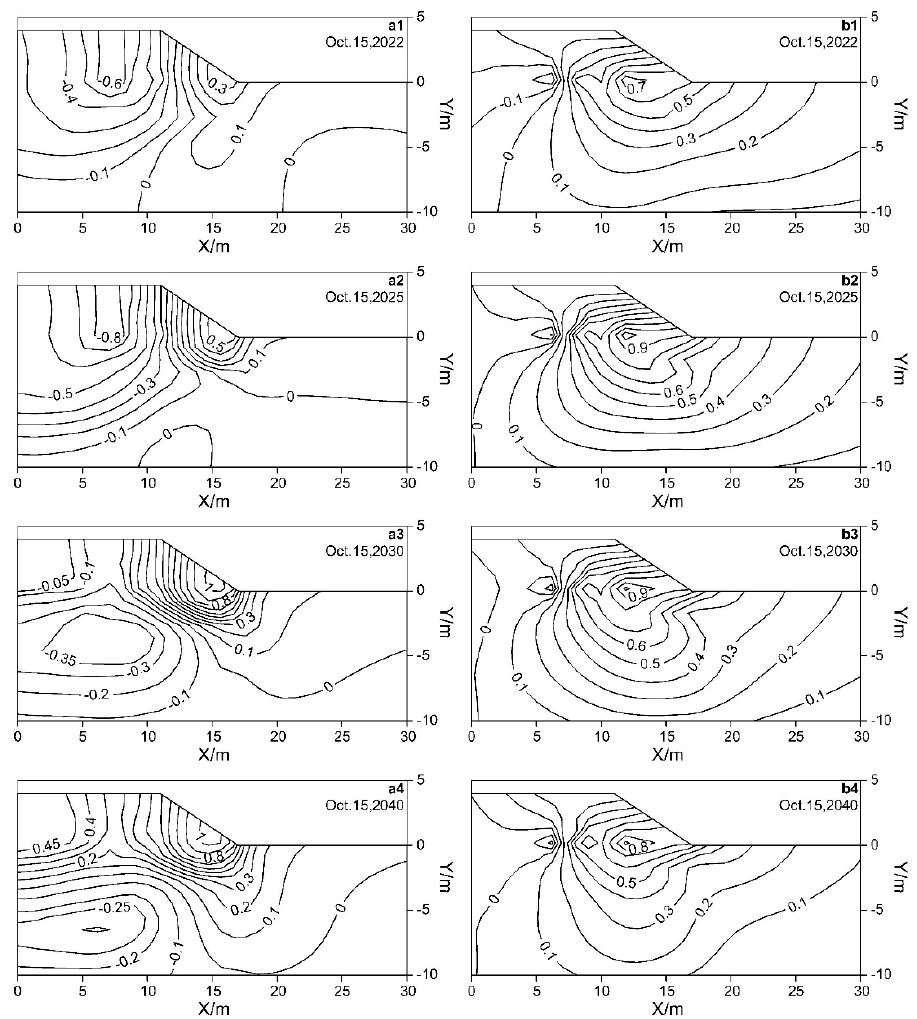
Figure 7. Distributions of vertical deformation and transverse deformation of the subgrade in warm seasons in different years: ( a1 – a4 ) vertical deformation distributions and ( b1 – b4 ) transverse deformation distributions. (Unit: cm.)